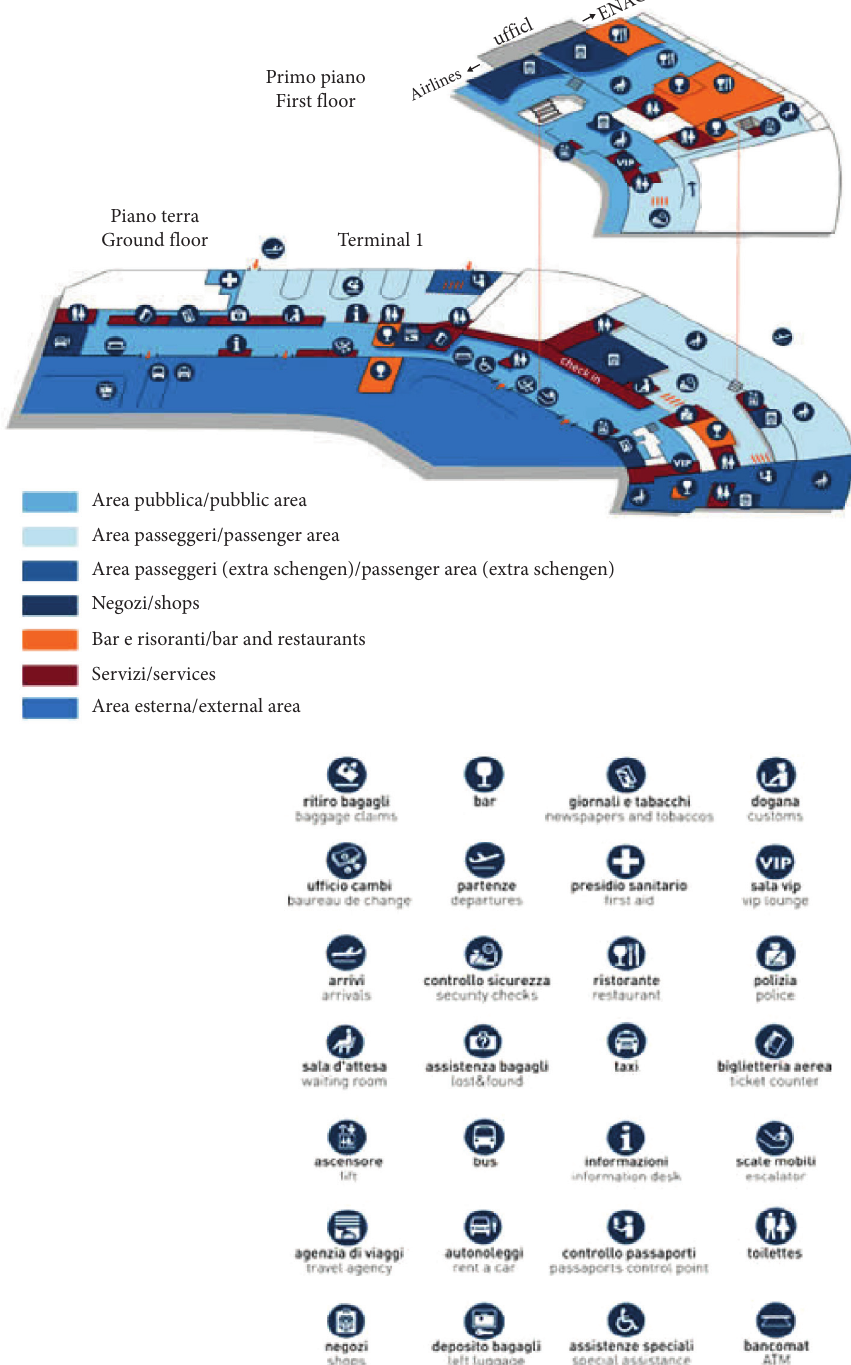
Figure 3: Terminal 1 of Naples Capodichino